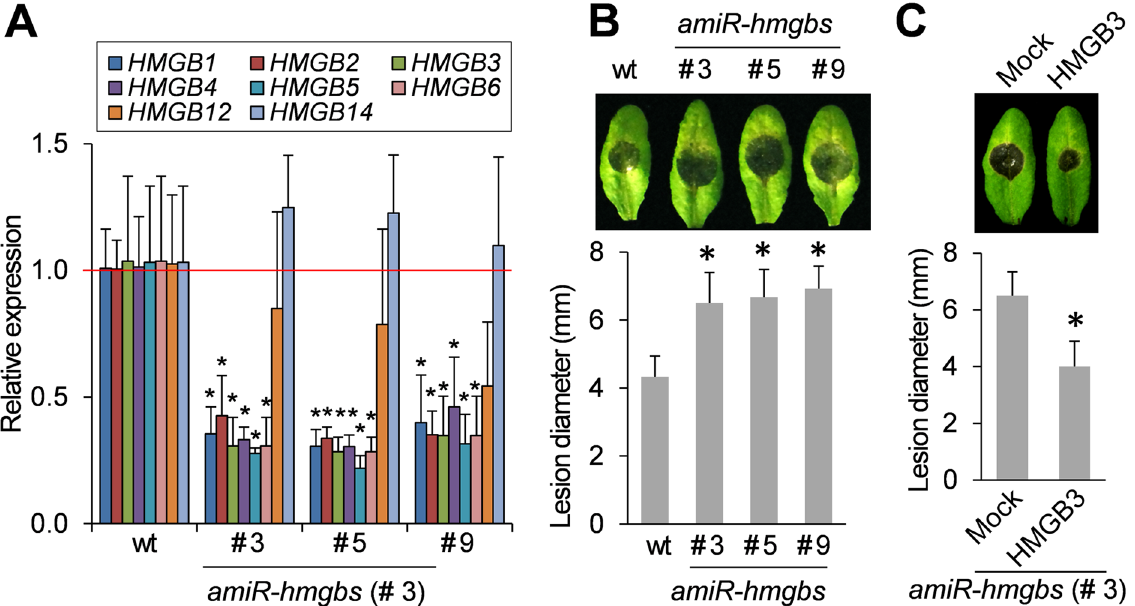
Fig 4. Silencing HMGB s increases susceptibility to B . cinerea . A. Relative expression of HMGBs ( HMGB1 - HMGB14 ) in 4-week-old plant from three different amiR-hmgbs lines (#3, #5 and #9) was compared to their expression levels in wt plants, which was set at 1 and denoted by a red line. Data are the mean ± SD (n = 4). B. amiR-hmgbs lines showed enhanced susceptibility to B . cinerea infection. Representative disease symptoms at 3 dpi are shown in the upper panel, and the data corresponding to this time point are presented in the lower panel as the mean ± SD (n = 6). C. Extracellular HMGB3 restored resistance of amiR - hmgbs transgenic plants (line # 3) to B . cinerea . Leaves were infiltrated with water containing 1 μ M HMGB3 one day before B . cinerea infection. Representative disease symptoms at 3 dpi are shown in the upper panel. Data corresponding to this time point are presented as the mean ± SD (lower panel, n = 6). Asterisks indicate significant differences from the untransformed wt plants in A and B or mock-treated amiR - hmgbs transgenic plants in C ( t test, P < 0.05).